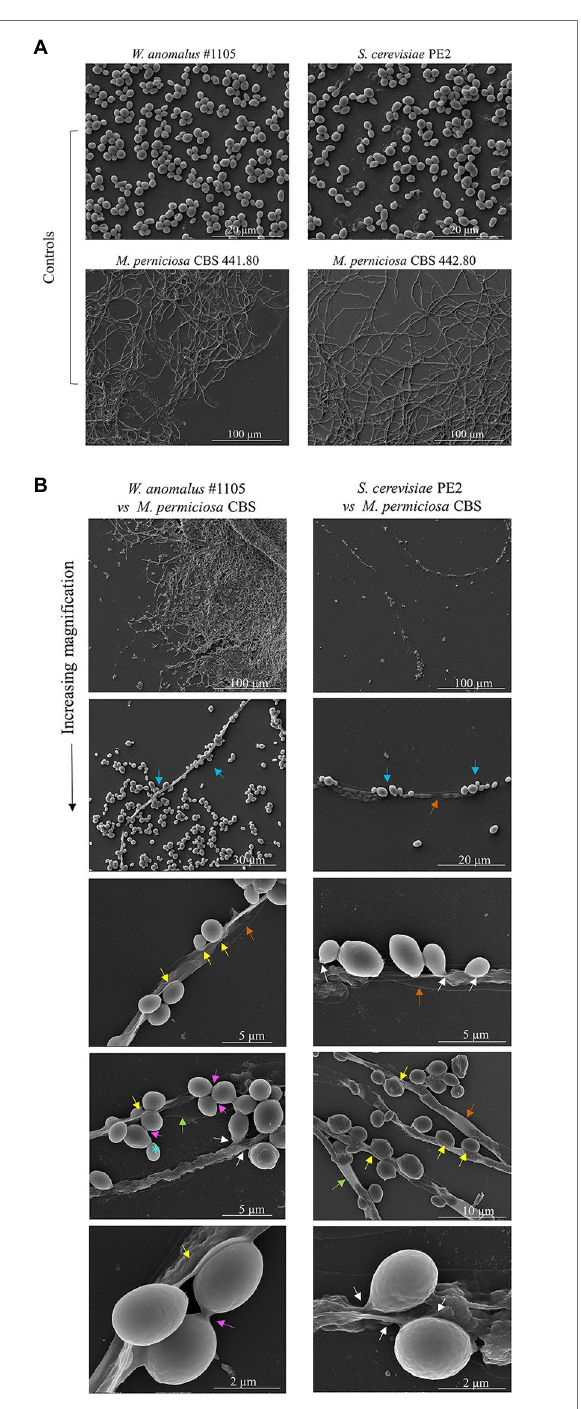
FIGURE 5 | SEM micrographs of W. anomalus #1105 vs CBS 441.80 and S. cerevisiae PE2 vs CBS 442.80 co-cultured cells. (A) Controls images of yeasts and filamentous fungi growing separately in MEA at 30 ° C. (B) Increasing magnification micrographs show: the yeasts rather group while adhering to the hyphae (blue arrows); hyphae are drained (orange arrows); yeasts push into a hypha (yellow arrows); yeasts fuse with hyphae (white arrows). Bottom micrograph showing high magnification of W. anomalus #1105 shows that the yeast cells are ligated to each other (pink arrow), differently than from an incomplete bud separation